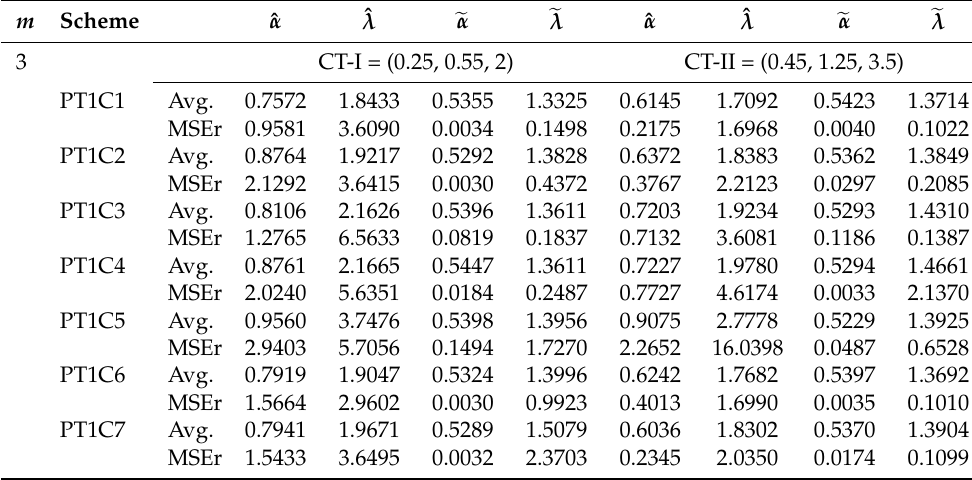
Table 3. Average estimated values and MSErs of the ML and BEs for NH model with α = 0.5 and λ = 1.5 under various censoring schemes at n =